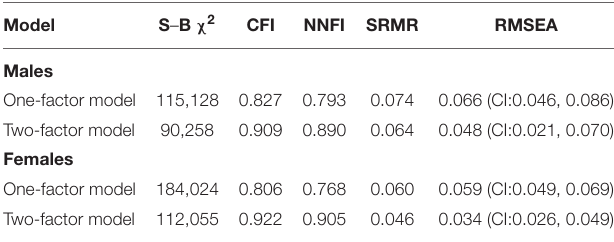
TABLE 3 | Summary of fit indices for the CFAs of SRQ for males ( n = 176) and females ( n = 524). Model